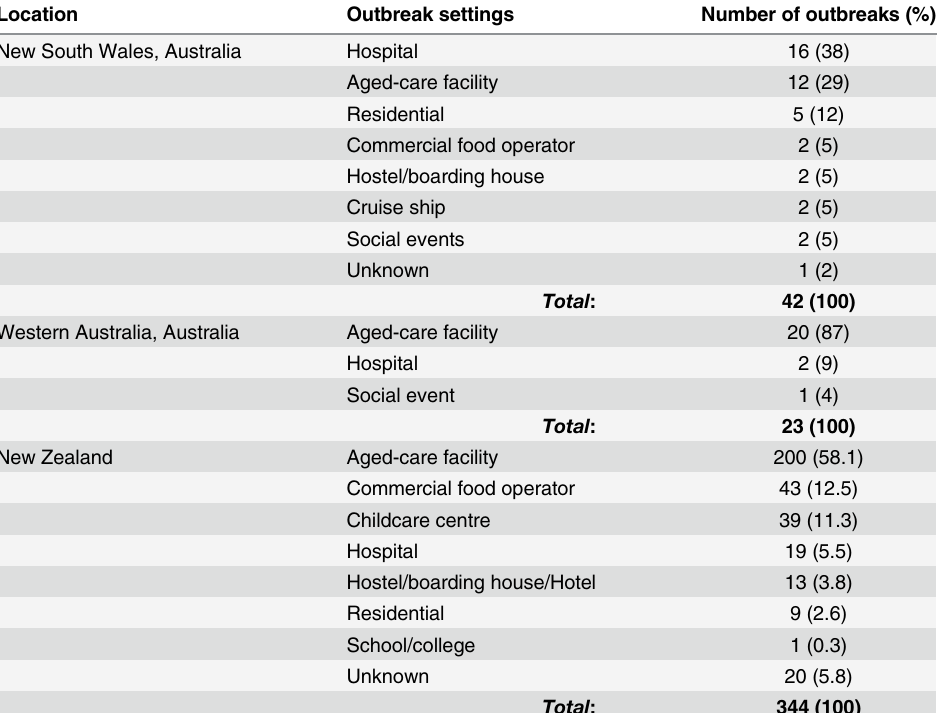
Table 2. NoV outbreak settings in Australia and New Zealand between January 2013 and June 2014.